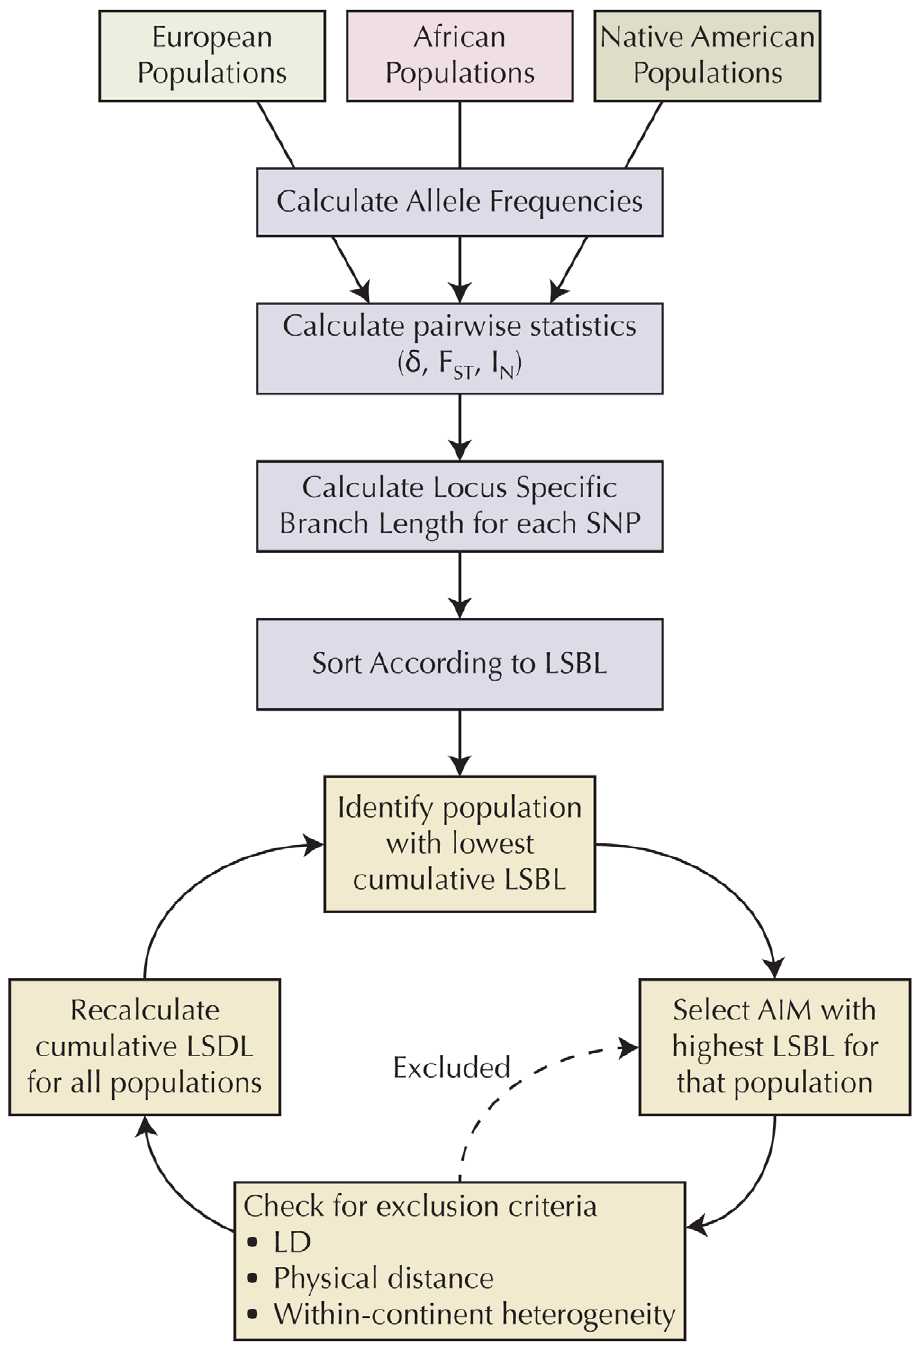
Figure 5. Algorithm for selecting AIMs.